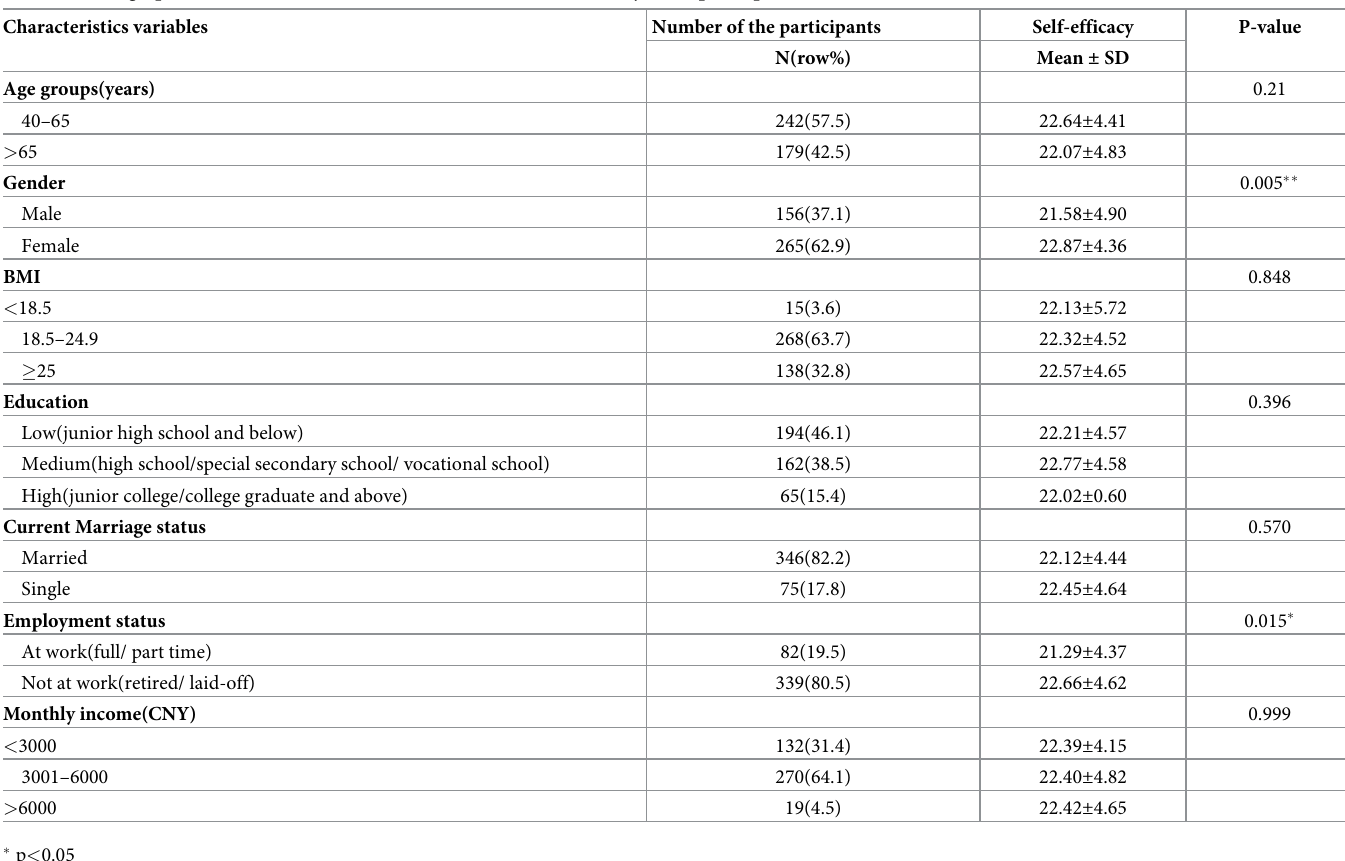
Table 1. Demographic characteristics and their associations with self-efficacy of the participants (N = 421).